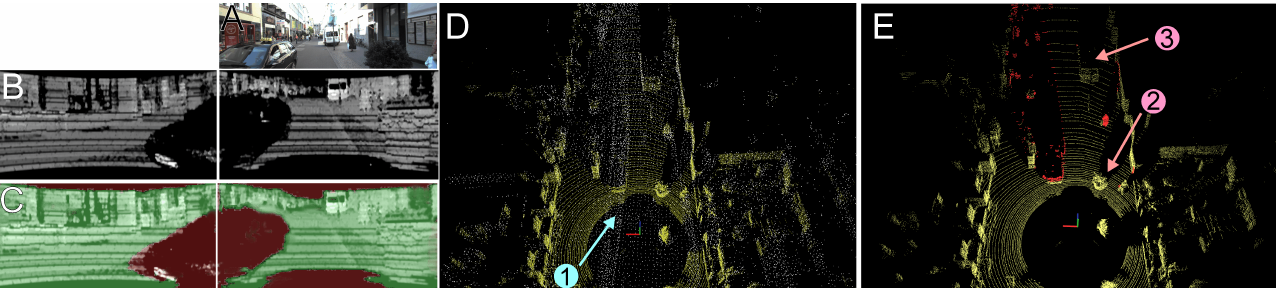
Figure 15. Detection and removal of non-stationary objects in a cluttered environment (KITTI MOTS sequence 19): frontal camera view ( A ), the synthesized intensity images that correspond to this image, but show that the LiDAR has a much larger field of view ( B ), motion segmentation masks for these images ( C ), accumulated point clouds showing the trail of laser points left by a moving car (denoted 1) and invalid points caused by pedestrians ( D ), and a single LiDAR scan clearly showing that while these points have been removed by our method, such stationary objects as a tree (denoted 2) and a parked truck (denoted 3) are not affected ( E